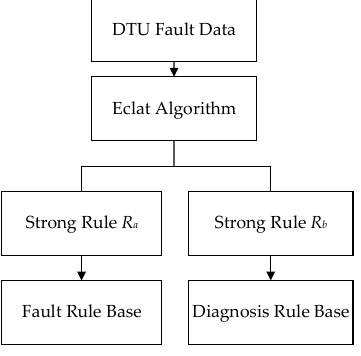
Figure 5. DTU fault analysis